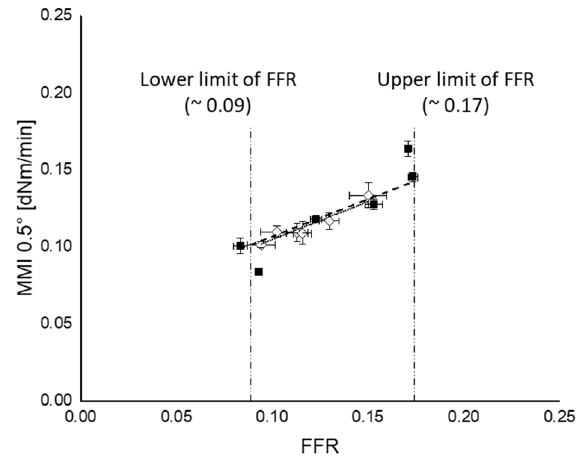
Figure 13. MMI 0.5° vs. FFR; (